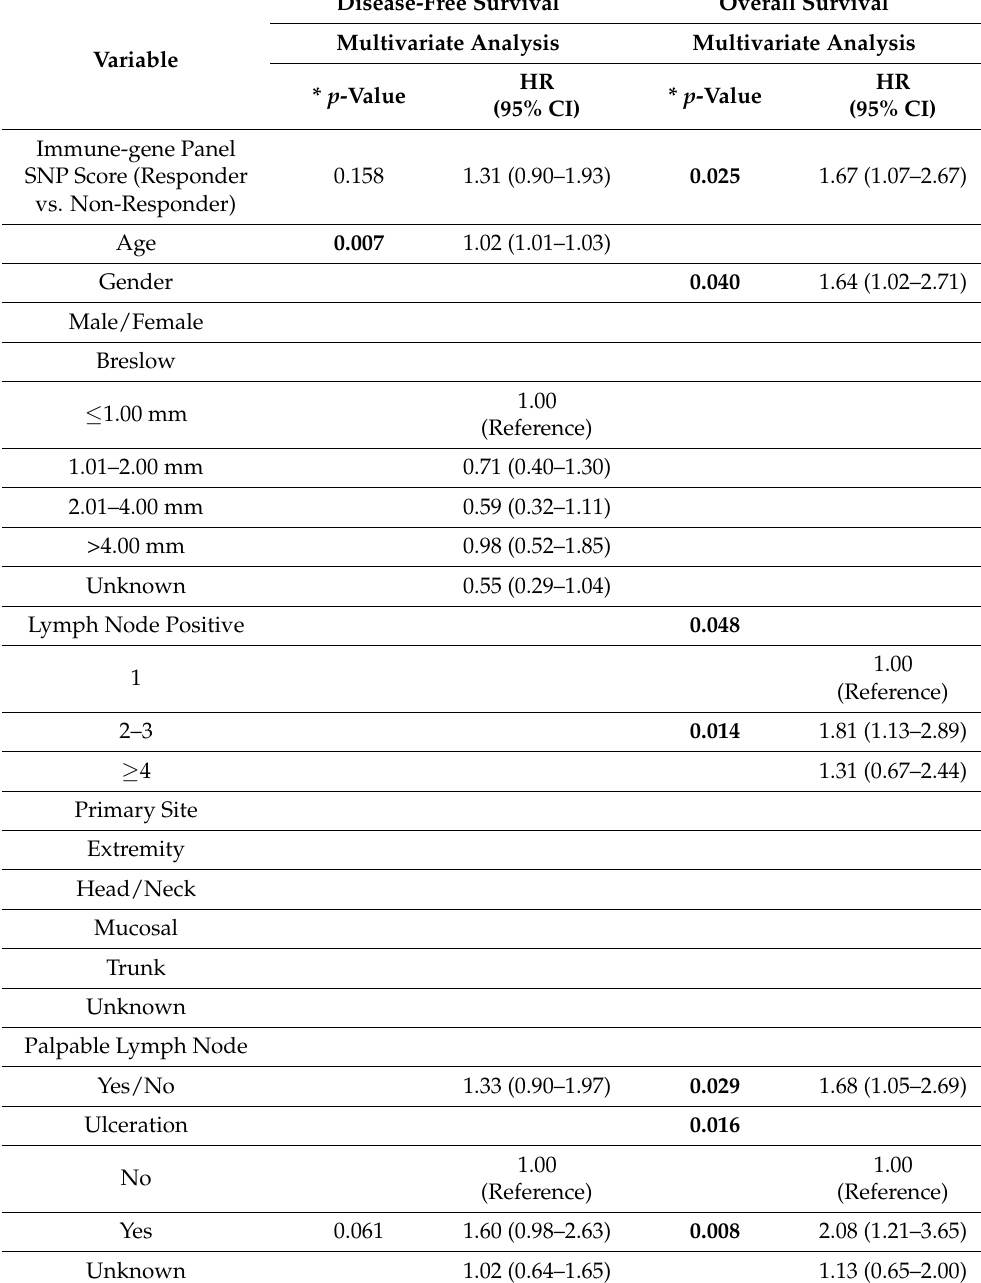
Table 3. Multivariable stepwise Cox regression analysis of survival: biomarker SNP panel and clinicopathologic characteristics in the validation cohort of MMAIT stage III BCG-treated patients. Disease-Free Survival Overall Survival Multivariate Analysis Multivariate Analysis Variable HR * p -Value * p -Value (95% CI) (95% CI) Immune-gene